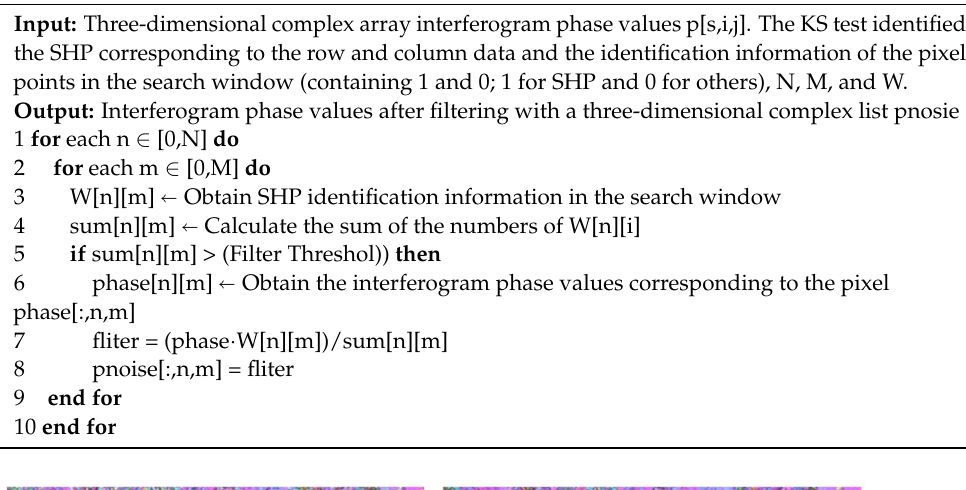
Algorithm 1. Serial Spatial Adaptive Filtering Algorithm